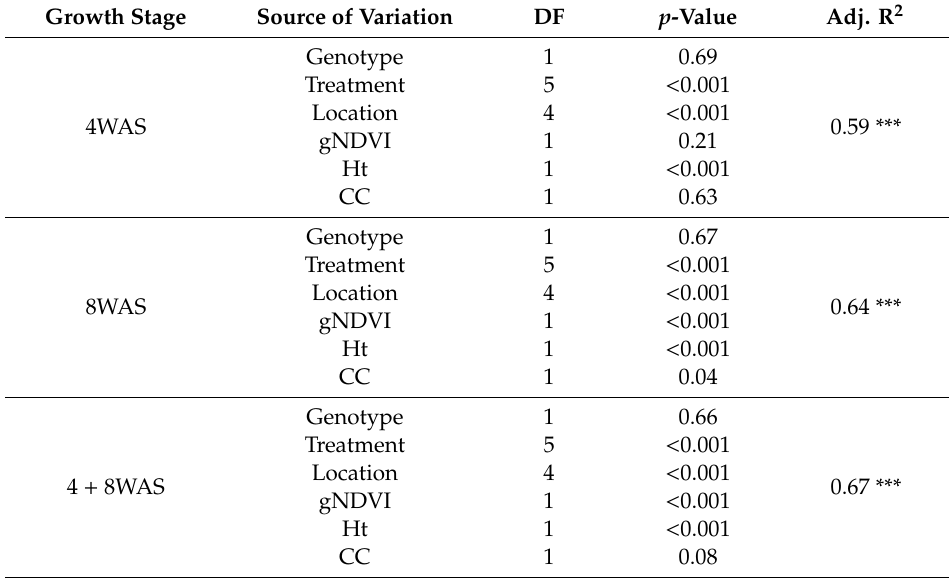
Table 1. Summary of multivariate assessment of yield variability in nutrient omission trial (NOT) plots established at multiple locations within smallholder maize-based system of Nigeria.